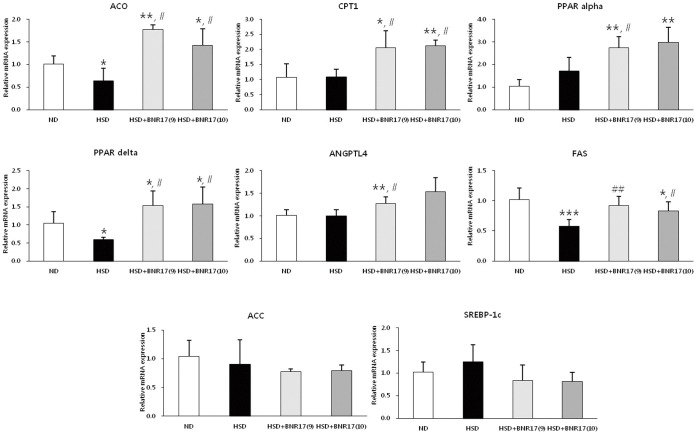

L. gasseri BNR17 affects mRNA expression in the liver.C57BL/6J mice were given ND, HSD, or HSD containing BNR17 (109 or 1010 CFU) for 10 weeks. The liver was then removed and mRNA expression was measured by real-time RT-PCR using β-actin as a housekeeping gene. Data represent the means ± SD. Pairwise t-test: *P<0.05, **P<0.01, versus the ND group; #
P<0.05, ##
P<0.01 versus the HSD group.